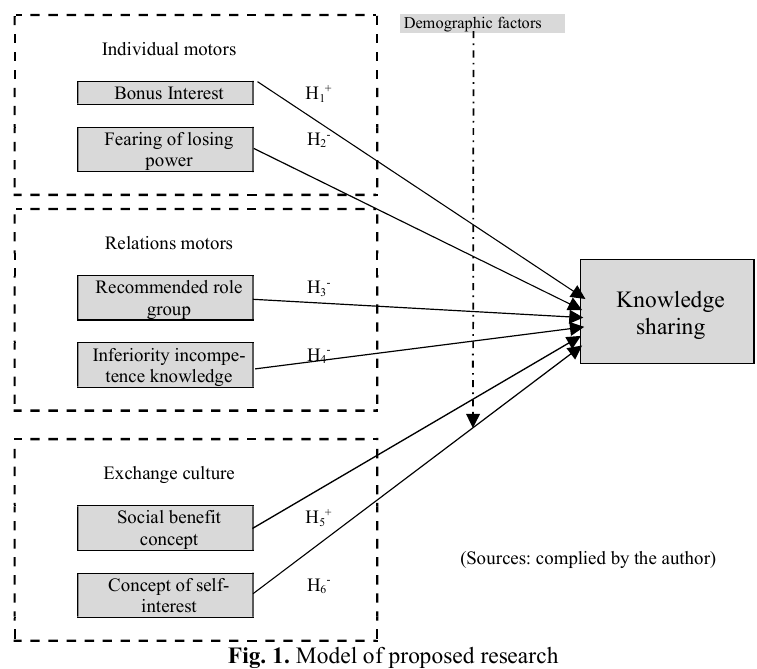
Fig. 1. Model of proposed